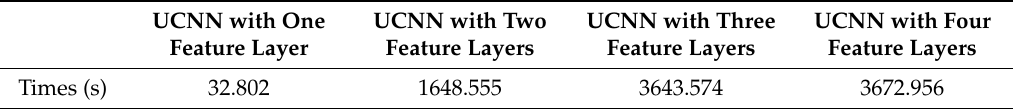
Table 14. Feature extraction times of different single features per one image scene.